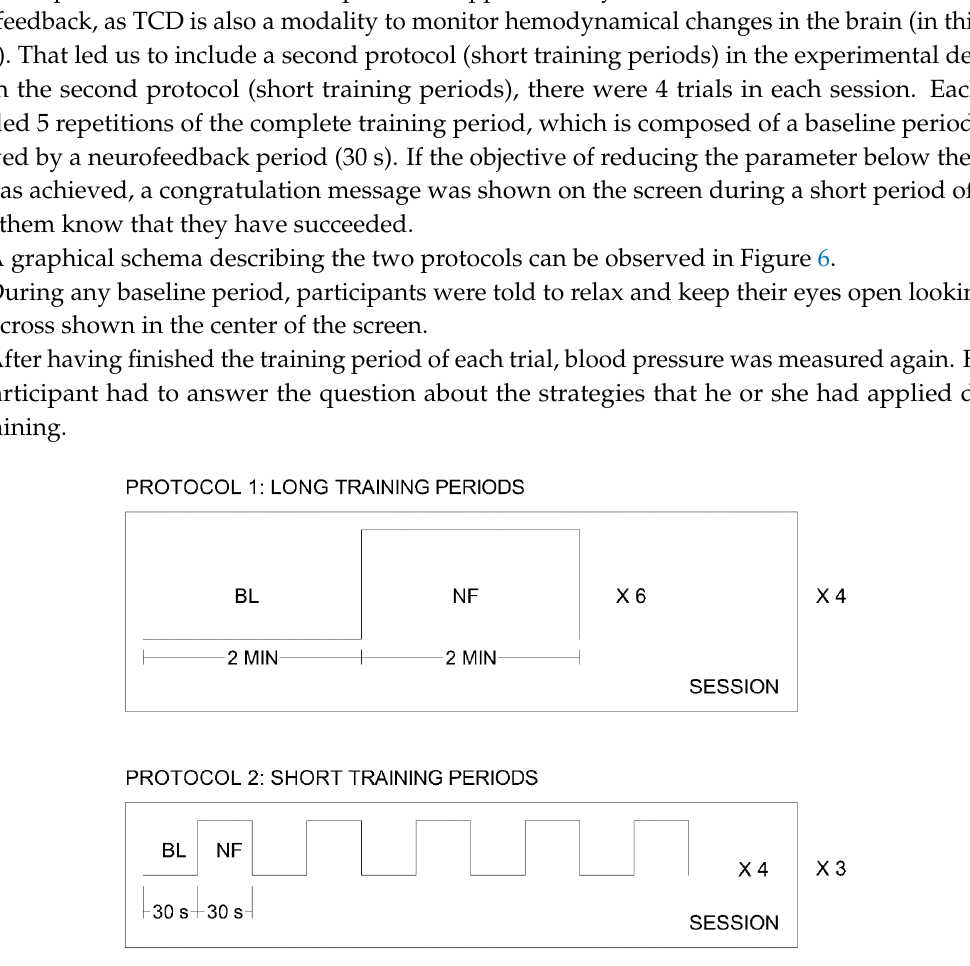
Figure 6. Schema of the two protocols applied in the validation sessions. Protocol 1 is composed of 4 sessions, with 6 trials in each session. A trial is composed of 2 min of baseline (BL) and 2 min of neurofeedback training (NF). Protocol 2 is composed of 3 sessions, with 4 trials in each session. A trial is composed of 5 repetitions of a 30-s baseline period (BL) and a 30-s neurofeedback period (NF).